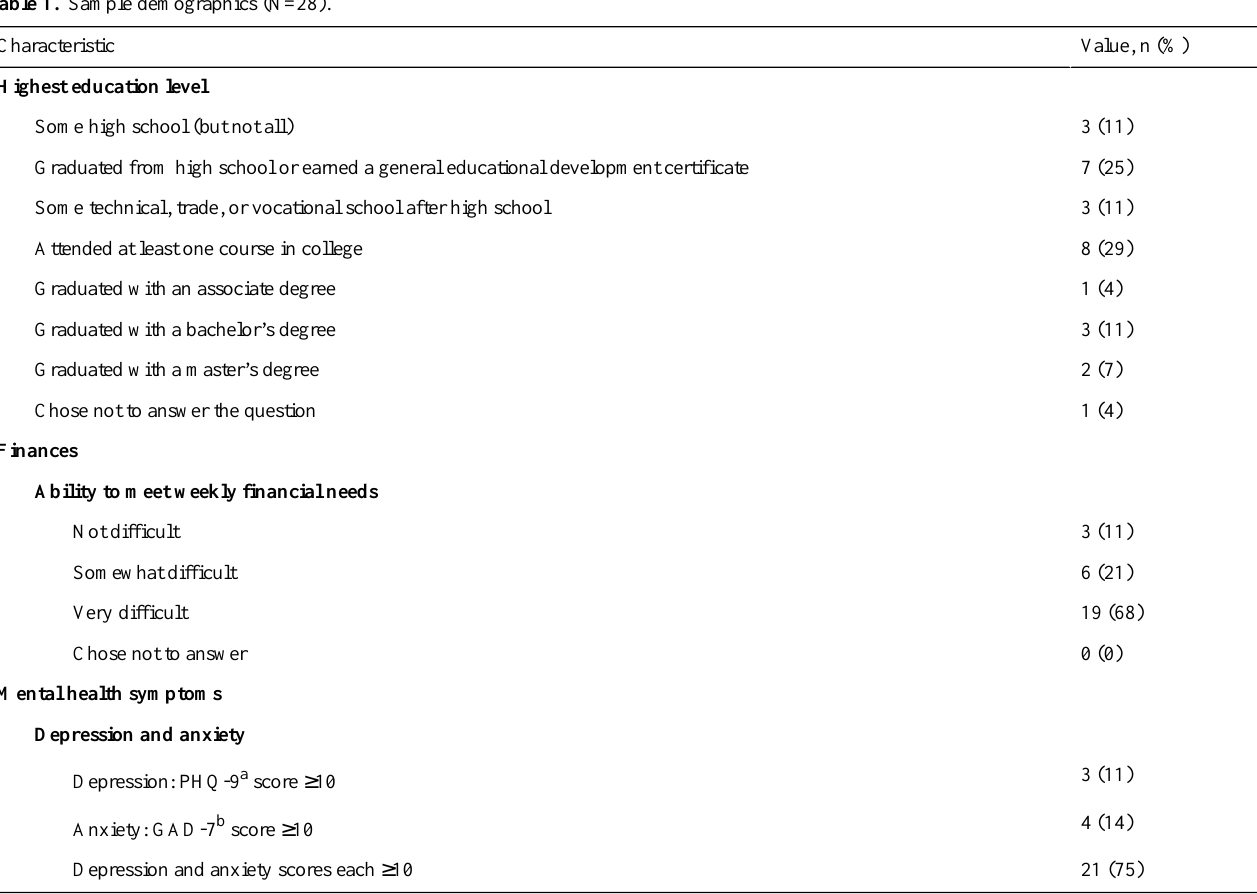
Table 1. Sample demographics